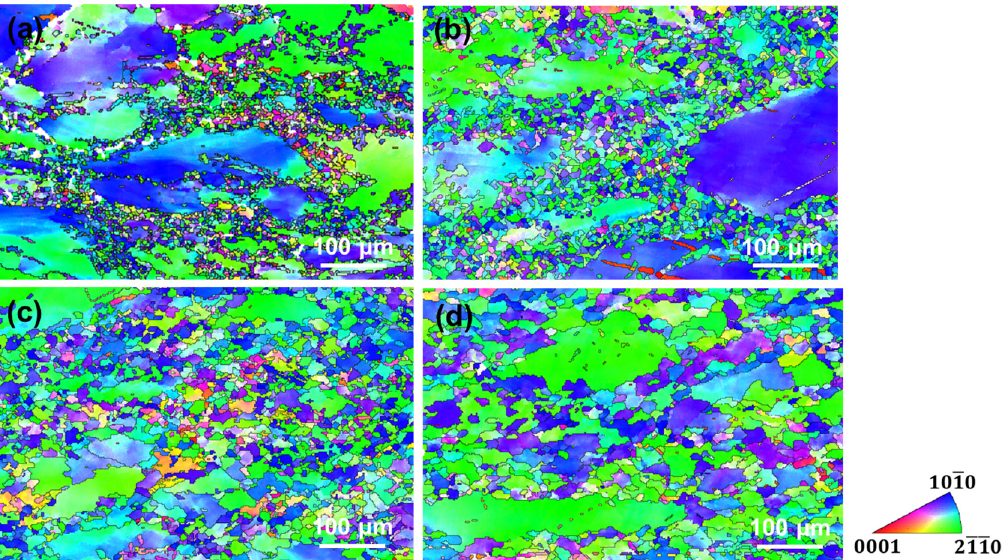
Figure 8. EBSD IPF maps of Mg-3Sn-2Al-1Zn-0.6Nd alloy under different hot deformation conditions: ( a ) 250 °C/0.01 s − 1 , ( b ) 300 °C/0.01 s − 1 , ( c ) 350 °C/0.01 s − 1 , and ( d ) 350 °C/0.001 s − 1 .